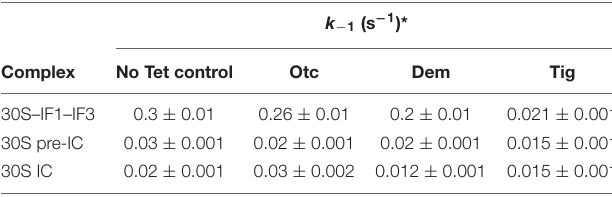
TABLE 2 | IF1 dissociation rate constants k − 1 in the presence of